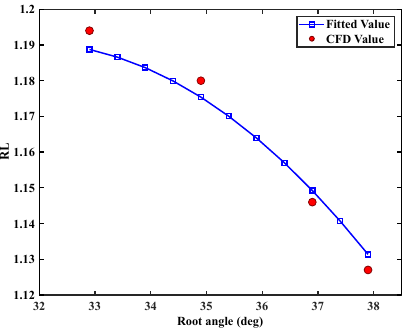
Figure 19. Hovering aerodynamic characteristics under different rotor root angles.